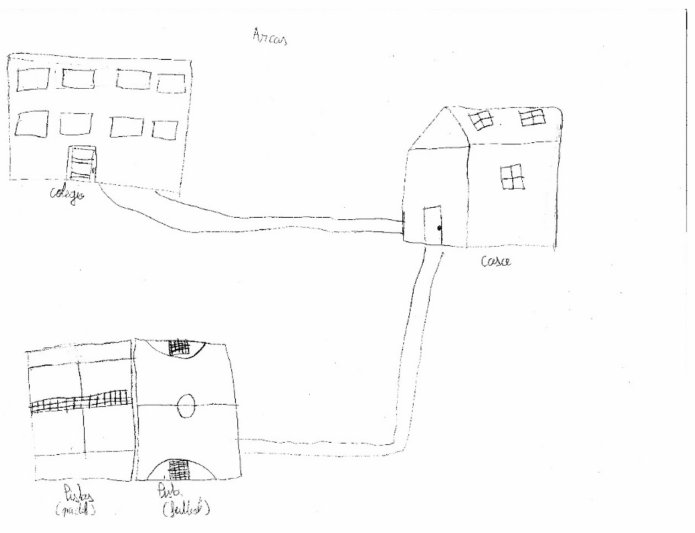
Figure 2. IP722. Boy, rural